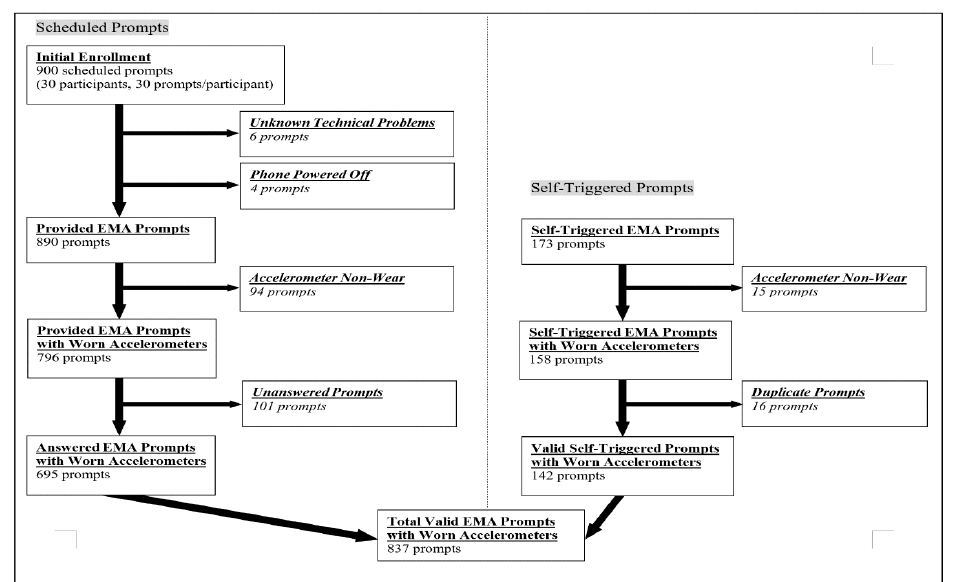
Figure A1. Synchronization of accelerometer data with EMA prompt times. An example from one participant for 24-h accelerometry data.